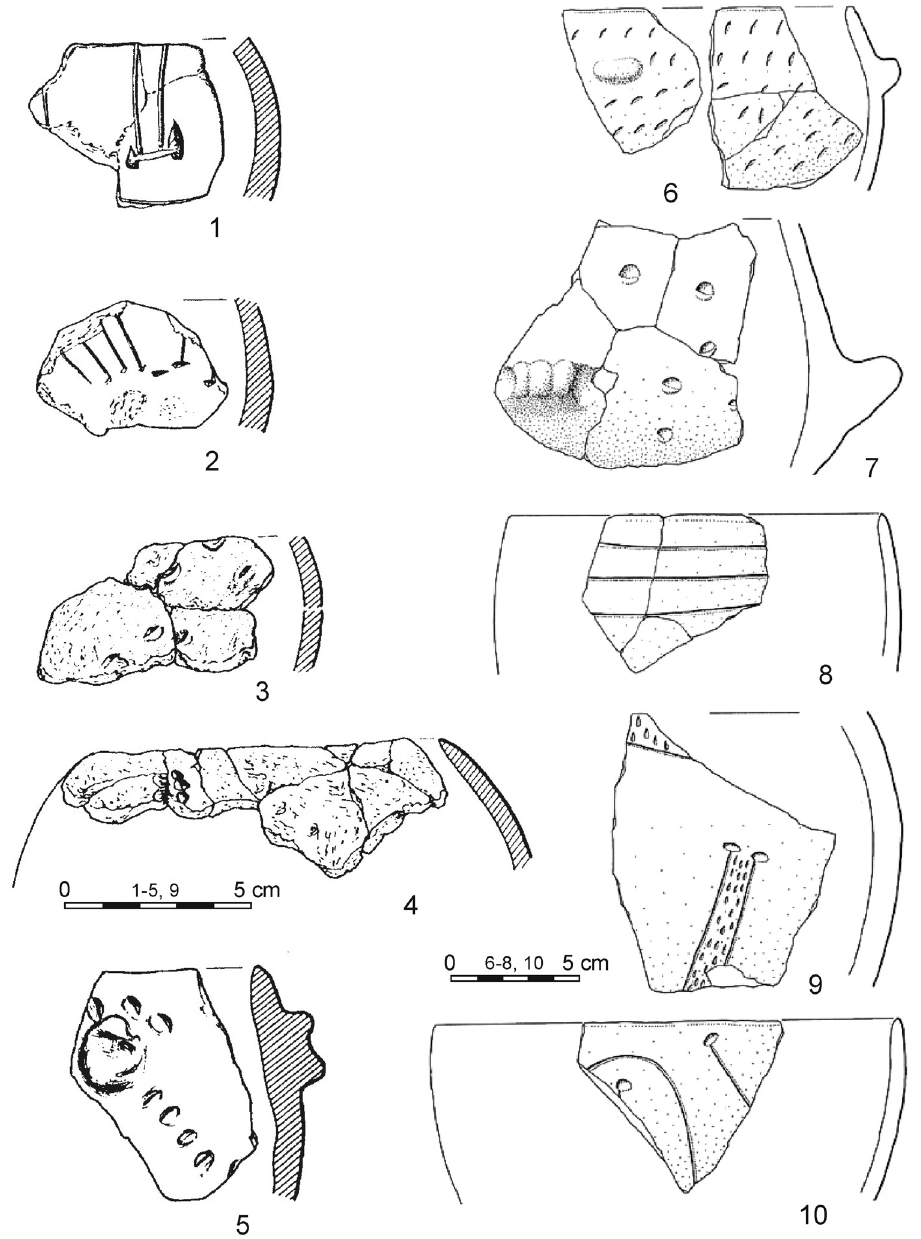
Figure 3: The LBK pottery from the extreme northern Lowlands. ( 1 – 5 ) Szczecin - P ł onia ( after Koz ł owska, 2004 ) , and ( 6 – 10